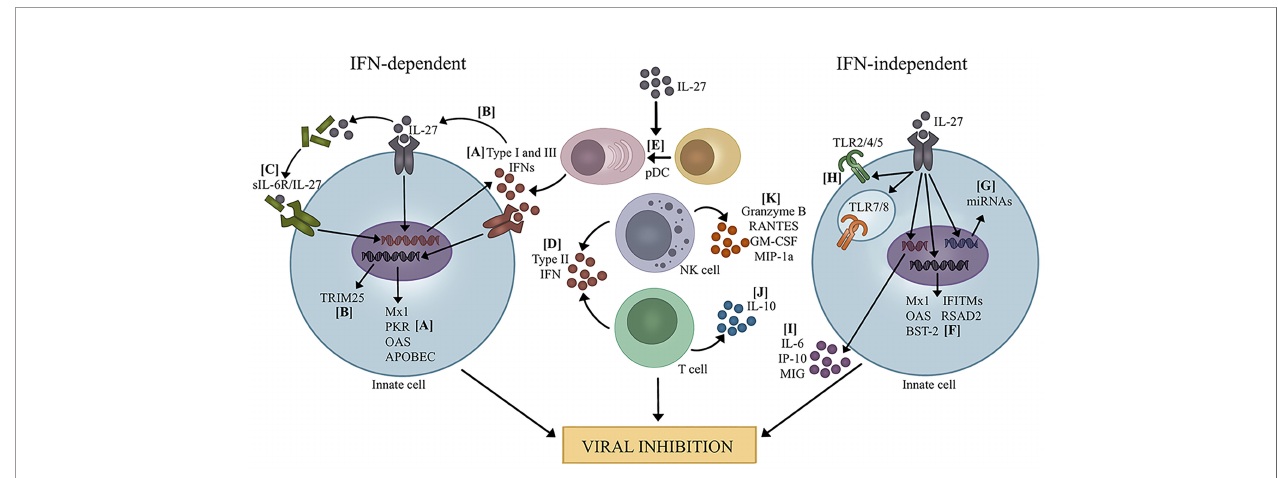
FIGURE 1 | Mechanisms of viral inhibition by IL-27. IFN-dependent: (A) IL-27 promotes the production of type I and III IFNs which leads to transcription of ISGs (20, 23, 29). (B) IL-27 induced by type I IFNs leads to expression of TRIM25 (21). (C) IL-27 complexes with sIL-6R and increases production of type I and III IFNs, leading to transcription of several ISGs (31, 33, 34). (D) IL-27 promotes the production of type II IFN by T cells and NK cells (28, 35, 51 – 54). (E) IL-27 promotes pDC differentiation, leading to increased IFN production (39). IFN-independent: (F) IL-27 directly promotes the transcription of several ISGs (19, 25, 27, 32, 38, 55). (G) IL-27 induces the expression of miRNAs that potentially target several viruses (56, 57). (H) IL-27 enhances the expression and signaling capacity of TLRs, which could in fl uence recognition of PAMPs and DAMPs during viral infection (10 – 15). (I) IL-27 increased pro-in fl ammatory cytokine and chemokine production (40). (J) IL- 27 promotes IL-10 production by T cells to mediate immunopathology during viral infection (18, 36, 37, 41, 58 – 61). (K) IL-27 enhances NK cell function by increasing granzyme B, RANTES, GM-CSF, and MIP-1 a (28,